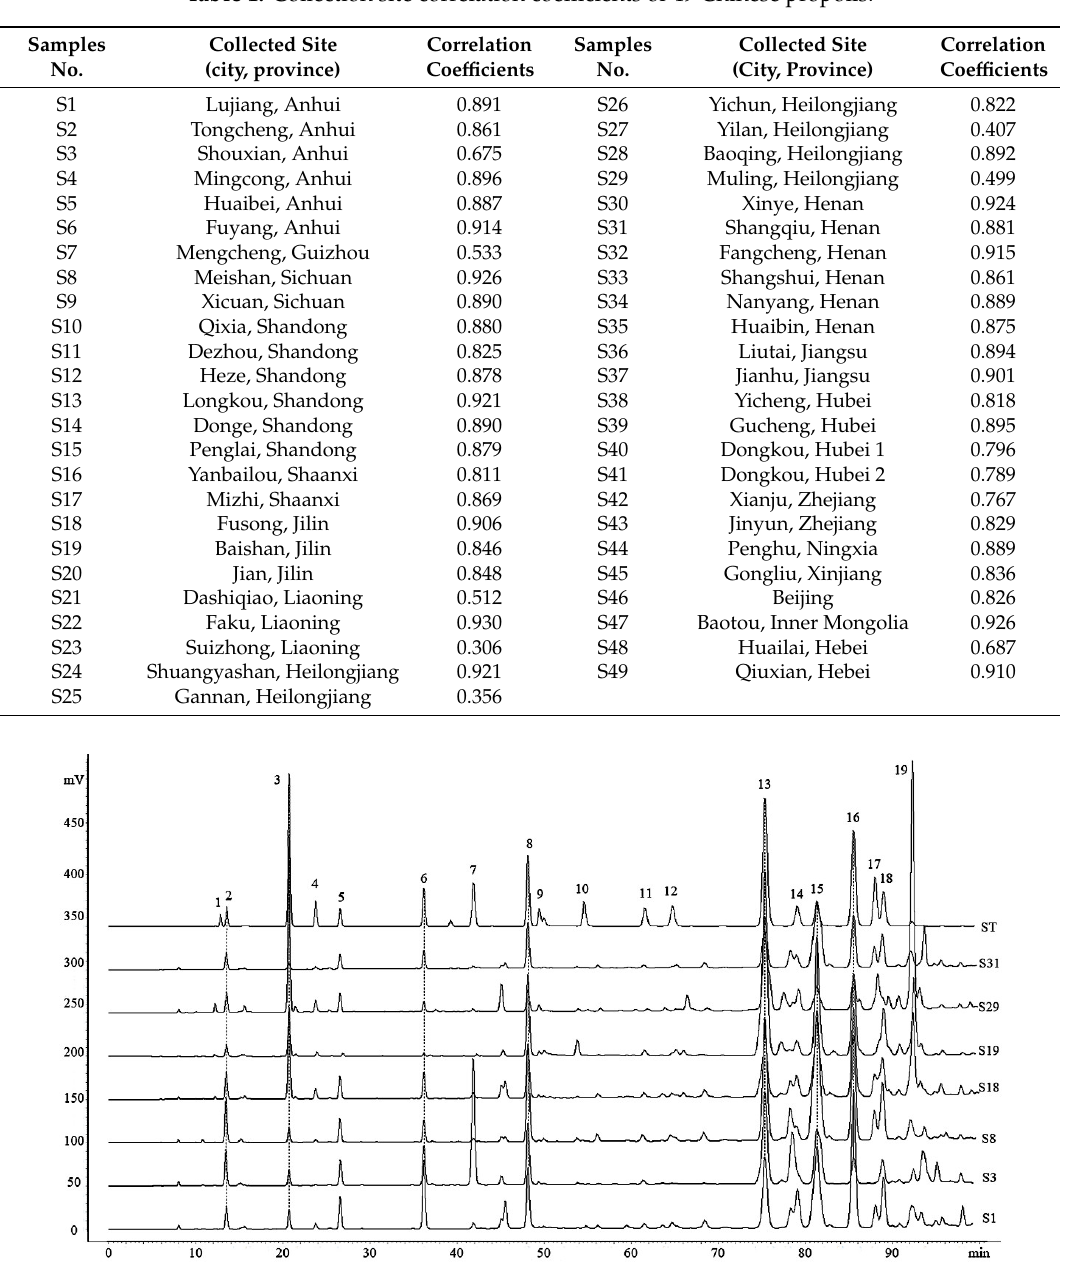
Table 1. Collection site correlation coefficients of 49 Chinese propolis. Samples No.